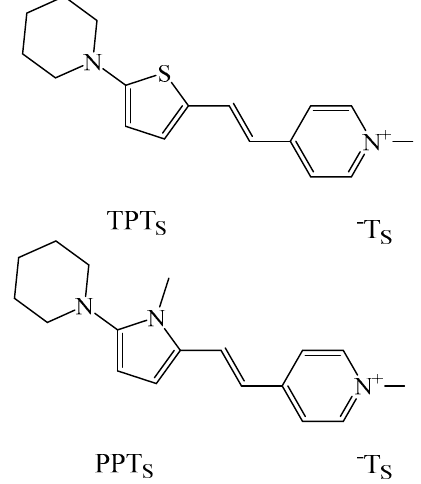
Figure 7. Molecular structures of TPT S and PPT S .